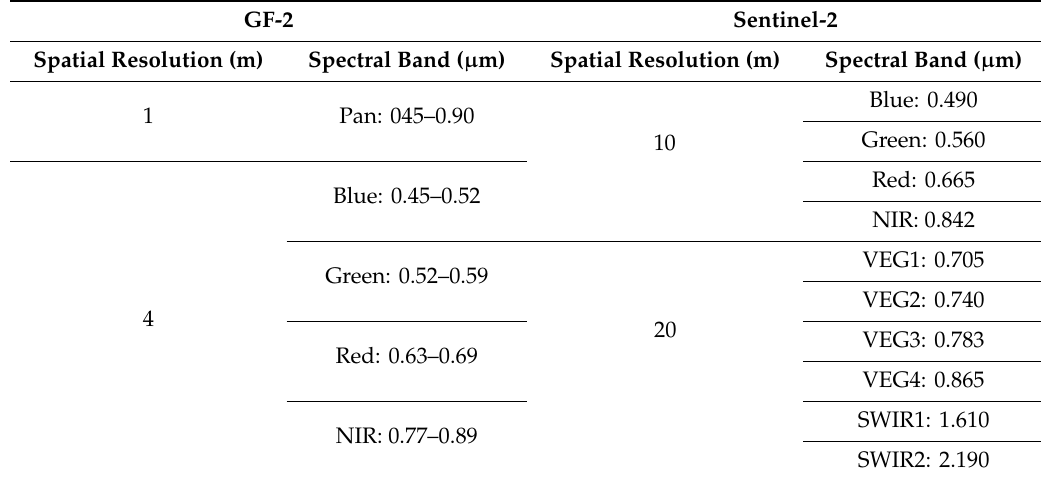
Table 2. GF2 and Sentinel-2 (S2) satellite sensor characteristics.